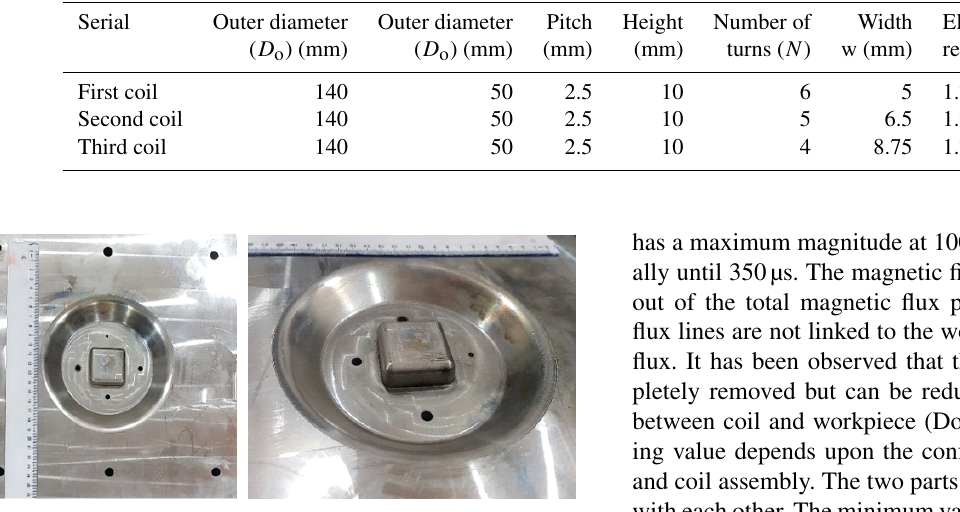
Figure 8. Die used in experimentation for electromagnetic forming of the Al 6061-T6